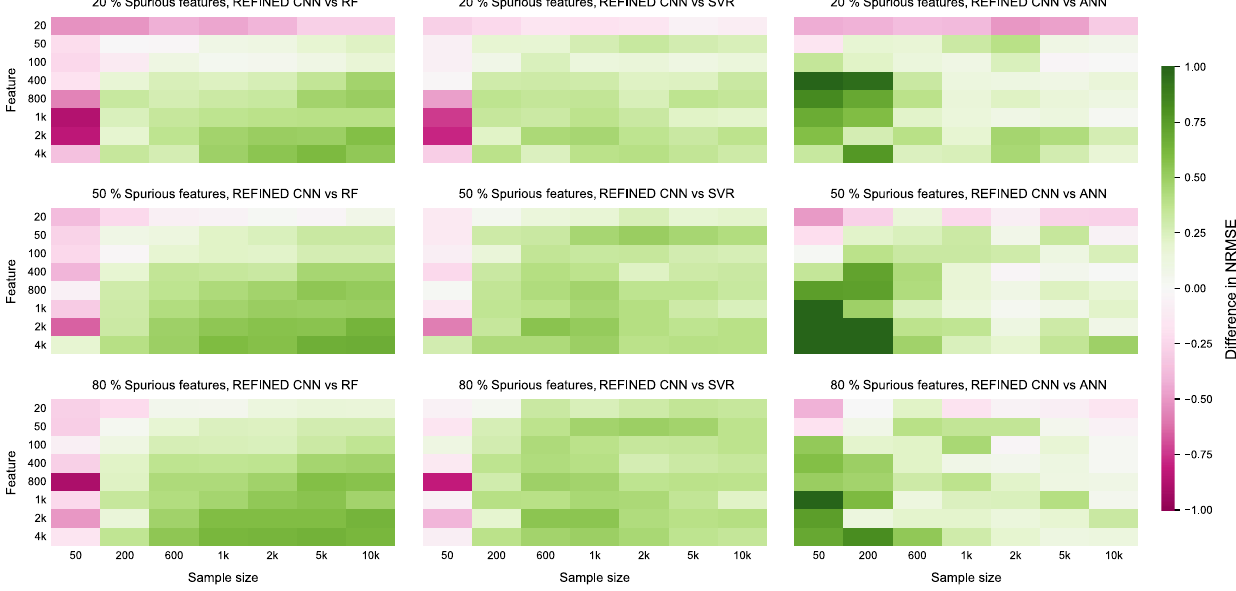
Fig. 2 Performance comparison for varying sample and feature sizes. Differences in NRMSE values for REFINED-CNN with three competing models (RF, SVR, and ANN) for different sample sizes and feature sizes containing varying degrees of spuriosity. Each green heatmap region denotes a case where REFINED-CNN outperforms the other